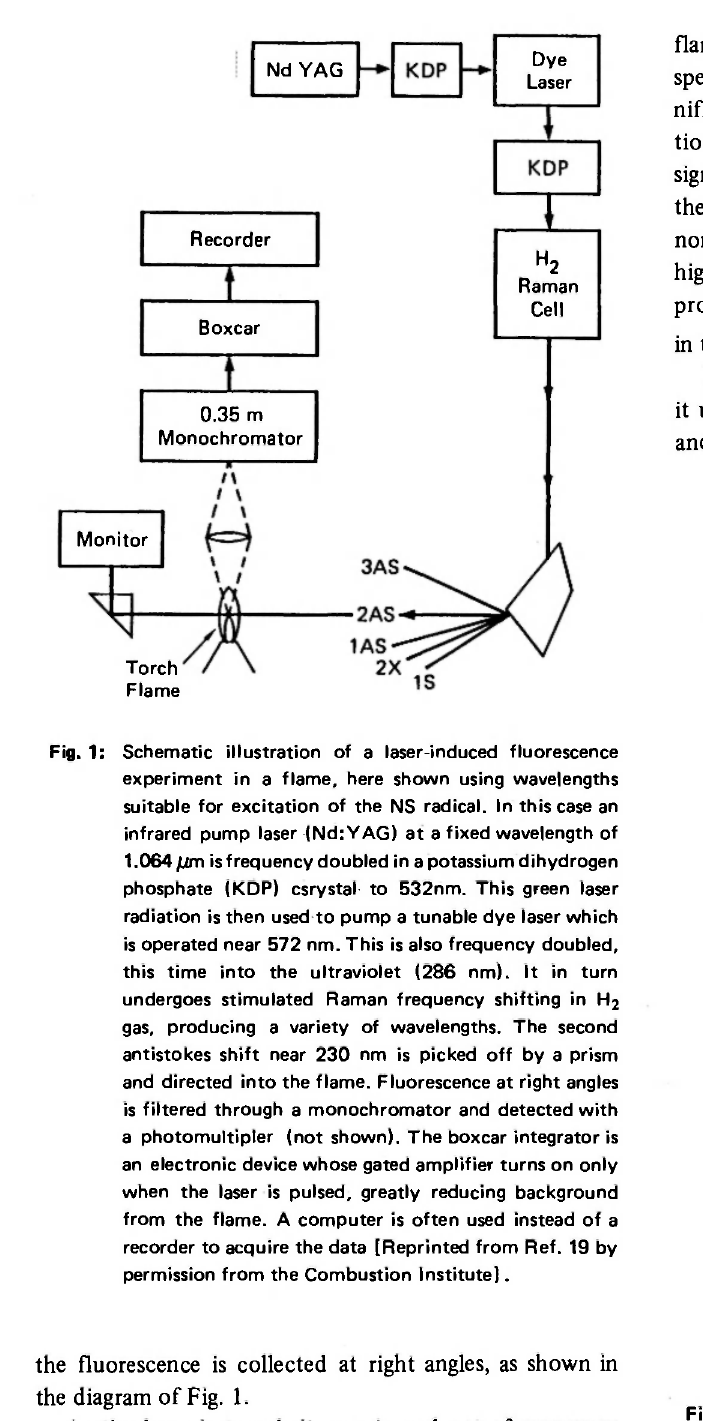
the fluorescence is collected at right angles, as shown in scan; here the laser was tuned through part of the ab- sorption spectrum of one particular transition of the CH molecule present in the reaction zone of a CH 4 /air